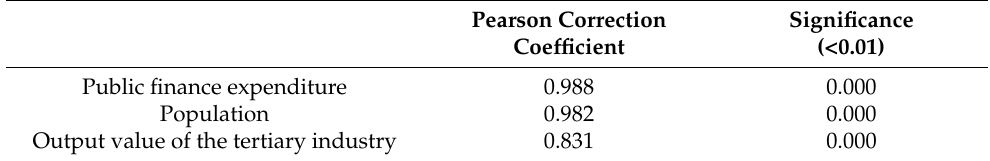
Table 6. Summary of the